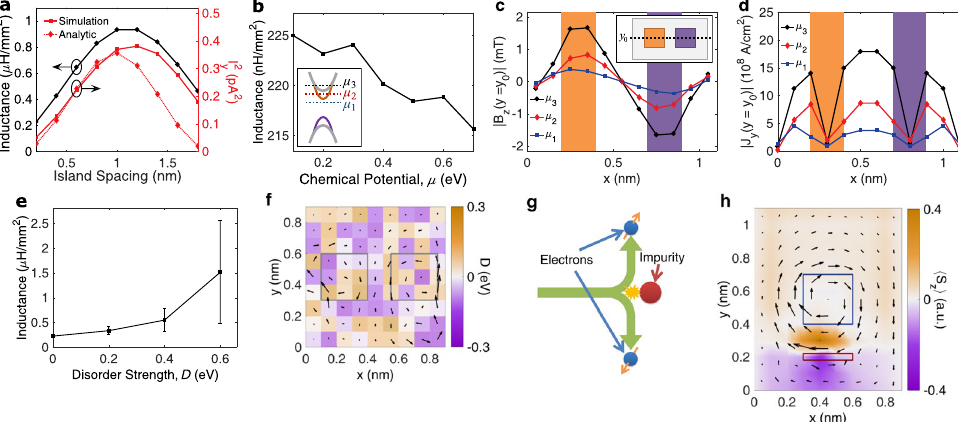
Figure 3. Device performance with respect to island spacing, chemical potential, and impurity disorder. ( a ) The inductance is maximized when a half-period of the input voltage signal is captured between the FIs and is 2 , which is calculated numerically and approximated proportional to the square of the current between the FIs, I y analytically. ( b ) Inductance at a frequency of 10 GHz as a function of chemical potential. The locations of = 0.1 eV, μ = 0.3 eV, and μ = 0.6 eV, which lie within the magnetic gap, inside only the surface bands, and μ 1 2 3 inside both the surface and bulk bands, respectively, are illustrated on the band structure schematic in the inset. ( c ) The magnetic field B z as a function of x at y = y 0 (see inset device schematic) increases with chemical potential. The shaded regions correspond to the location of FIs. ( d ) The current density J y at y = y 0 reveals